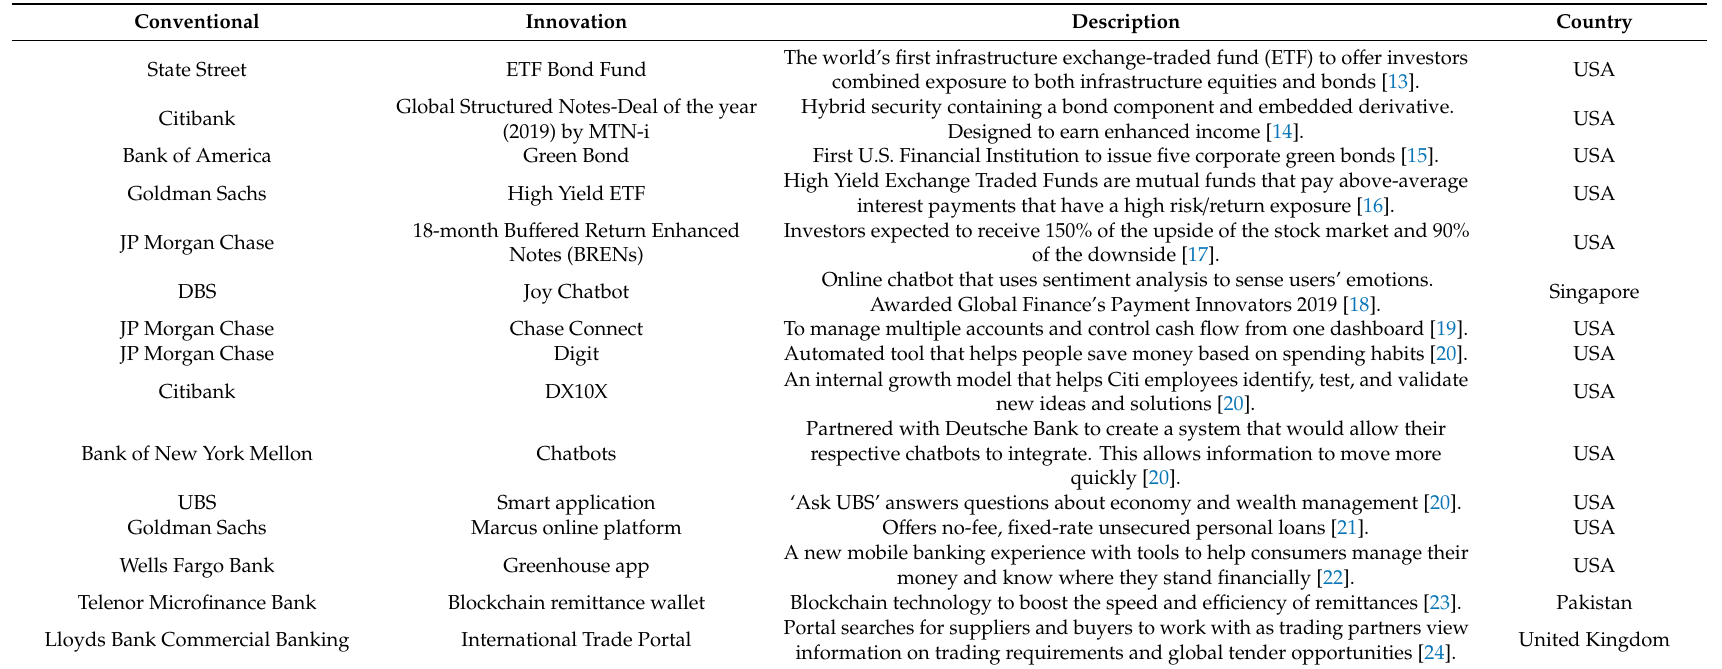
Table 1. Financial Innovation Comparison: Conventional versus Islamic Finance